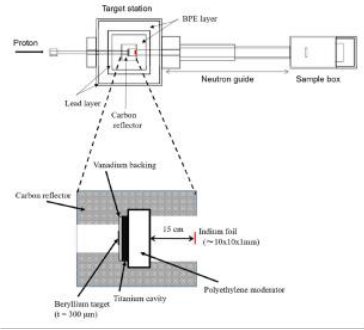
Table 1. RANS different types of moderator